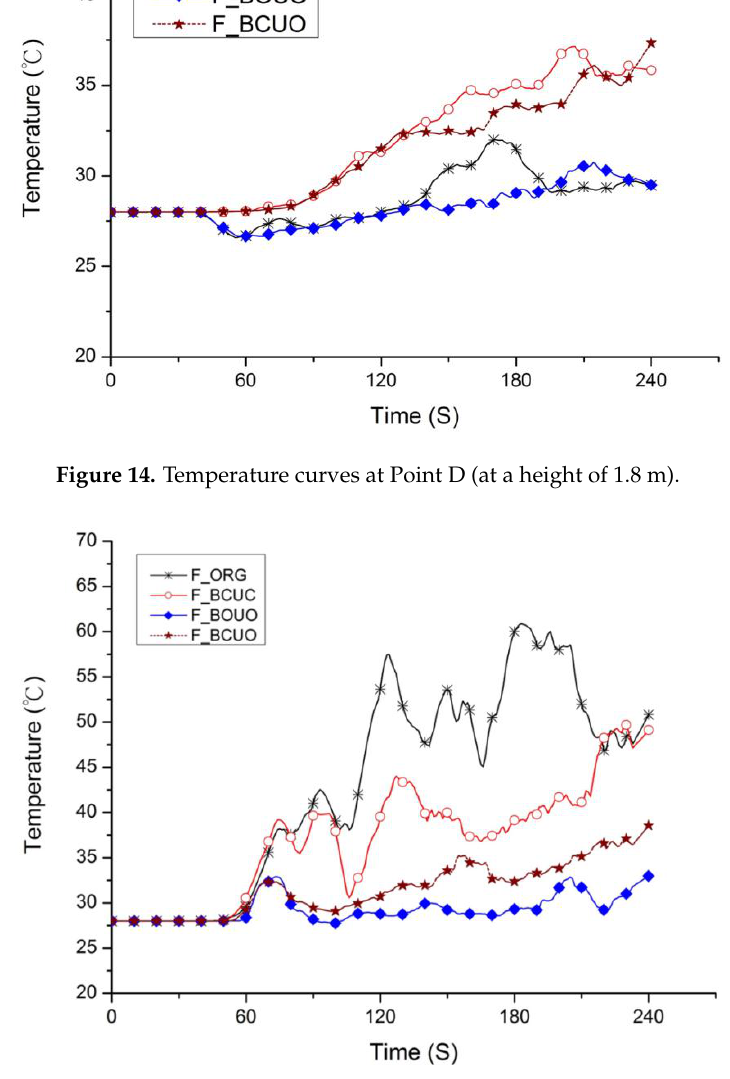
Figure 15. Temperature curves at Point R (at a height of 1.8 m).